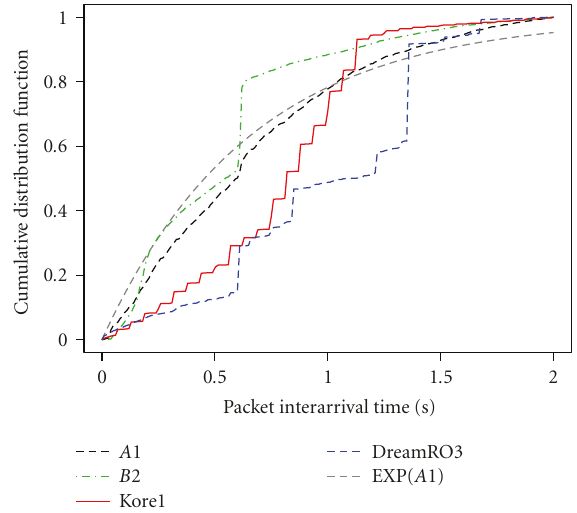
Figure 2: CDF of packet interarrival times.